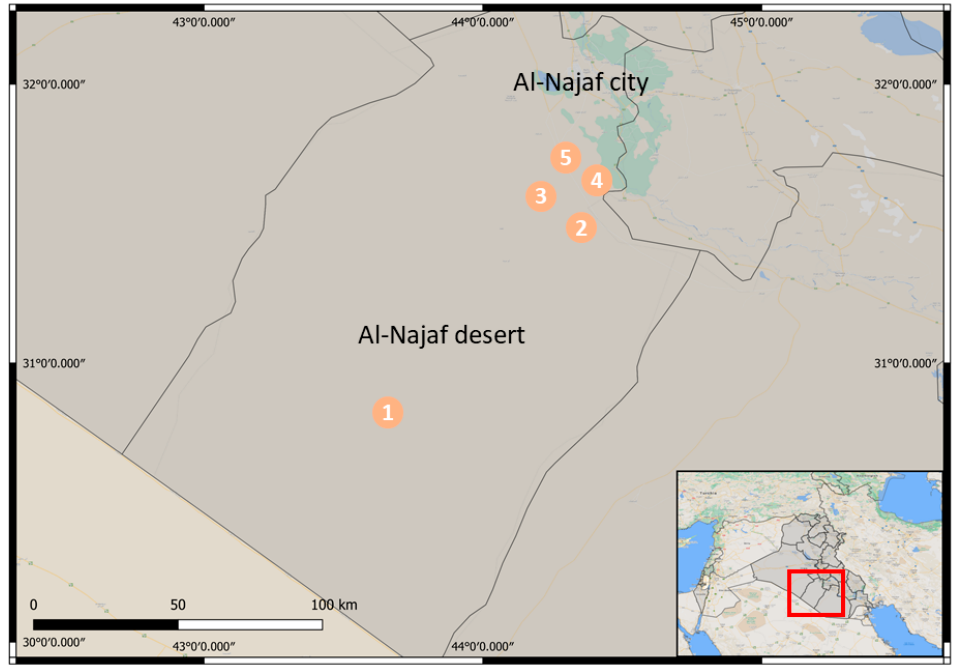
Figure 1. Locations of the five subpopulations of Vachellia gerrardii subsp. negevensis in the Al-Najaf desert (Iraq): ( 1 ) Birkat Al-Talhat, ( 2 ) Abu Talah stream (mid part), ( 3 ) Weier stream (initial part), ( 4 ) Abu Talah stream (terminal part), ( 5 ) Weier stream (terminal part).